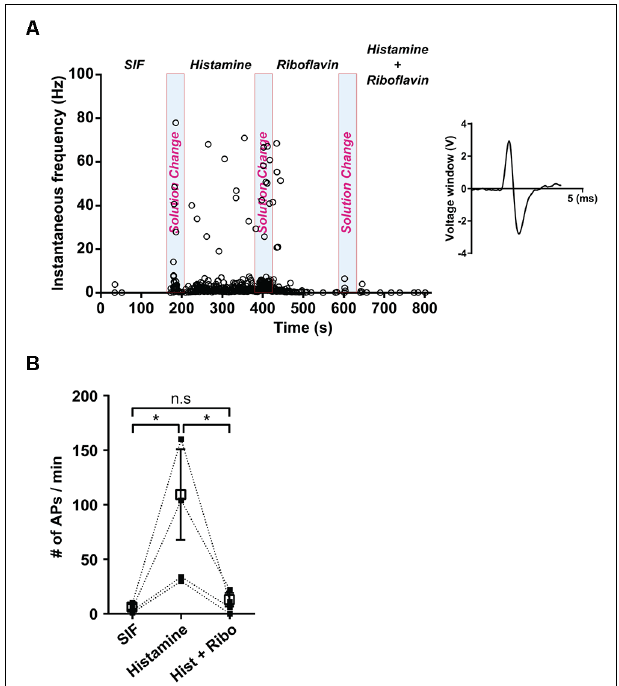
FIGURE 2 | Effect of riboflavin in histamine-induced peripheral sensory neural discharge. (A) The instantaneous response frequency from a representative single C-fiber with the application of synthetic interstitial fluid (SIF), histamine (500 µ M), and a combination of histamine (500 µ M) and riboflavin (100 µ M). Based on the AP’s shape, the number of generated nerve discharges was measured and the shape of AP was shown in the inset panel. Light blue shaded bars represent each period of solution change with the application of SIF, histamine, and a combination of histamine and riboflavin. (B) Spike counts from a single fiber during the control period of SIF administration and a corresponding histamine and riboflavin responsive period (* p < 0.05, n = 4). Open square represents mean of number of APs with SIF, histamine, and a combination of histamine and riboflavin. AP, action potential; Hist, histamine; Ribo, riboflavin; n.s., not significant. FIGURE 3 | The inhibitory effects of riboflavin on histamine- or